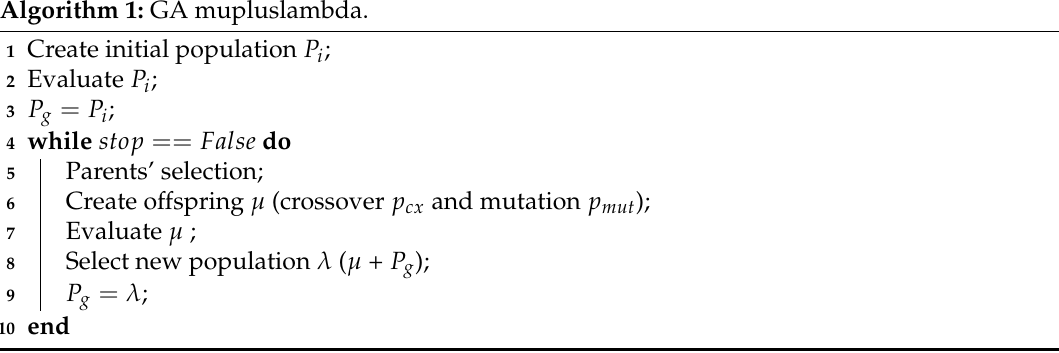
Algorithm 1: GA mupluslambda.